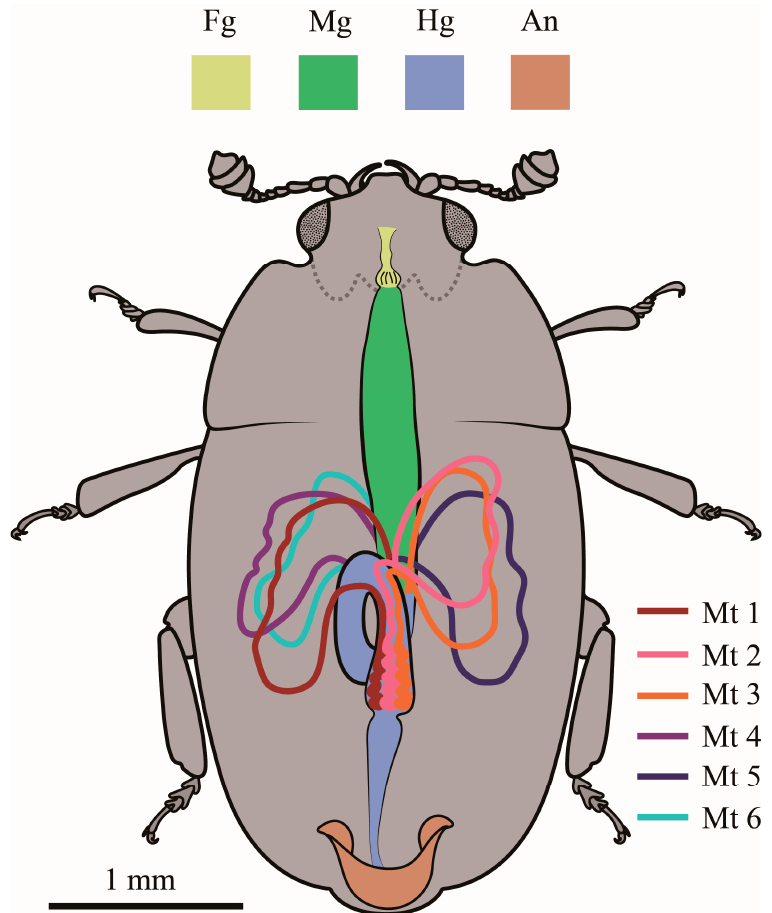
Figure 1. Schematic color picture (in dorsal view) of the dissected Meligethes ( Odonthogethes ) chinensis , showing the distribution of the alimentary canal and Malpighian tubules in the hemocoelic cavity. Fg: foregut, Mg: midgut, Hg: hindgut, An: anus, Mt: Malpighian tubule.